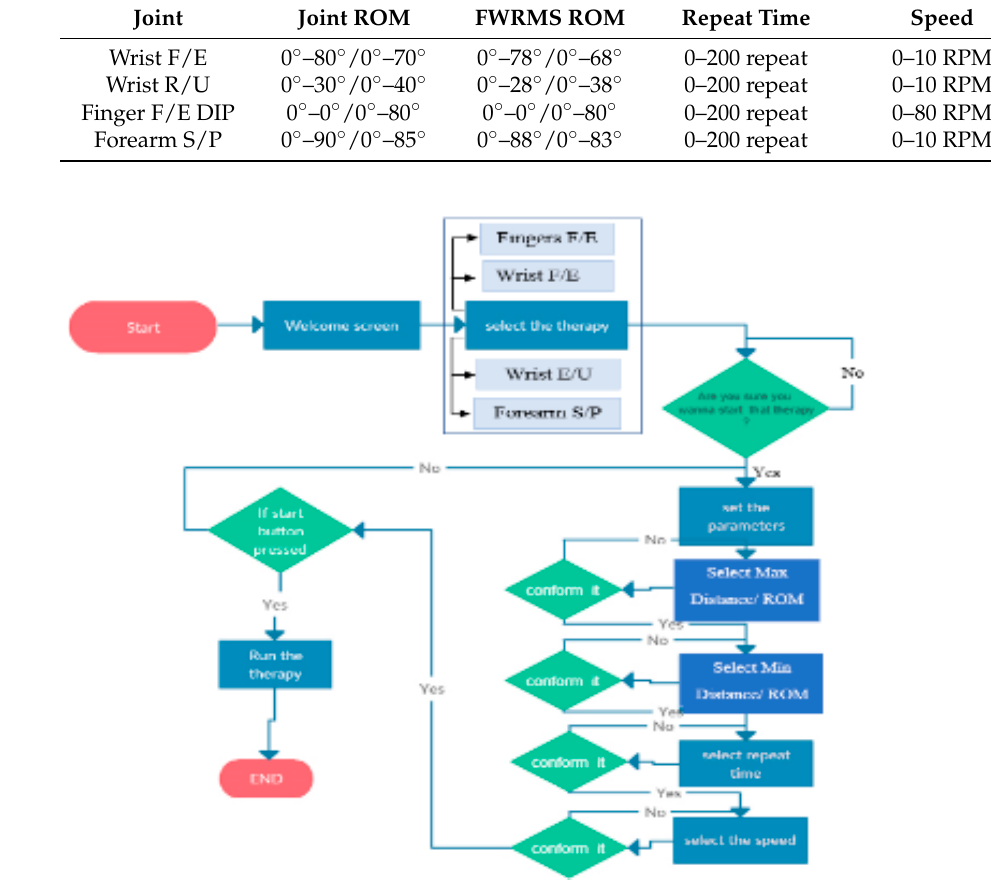
Figure 9. The software flow chart of the control strategy.